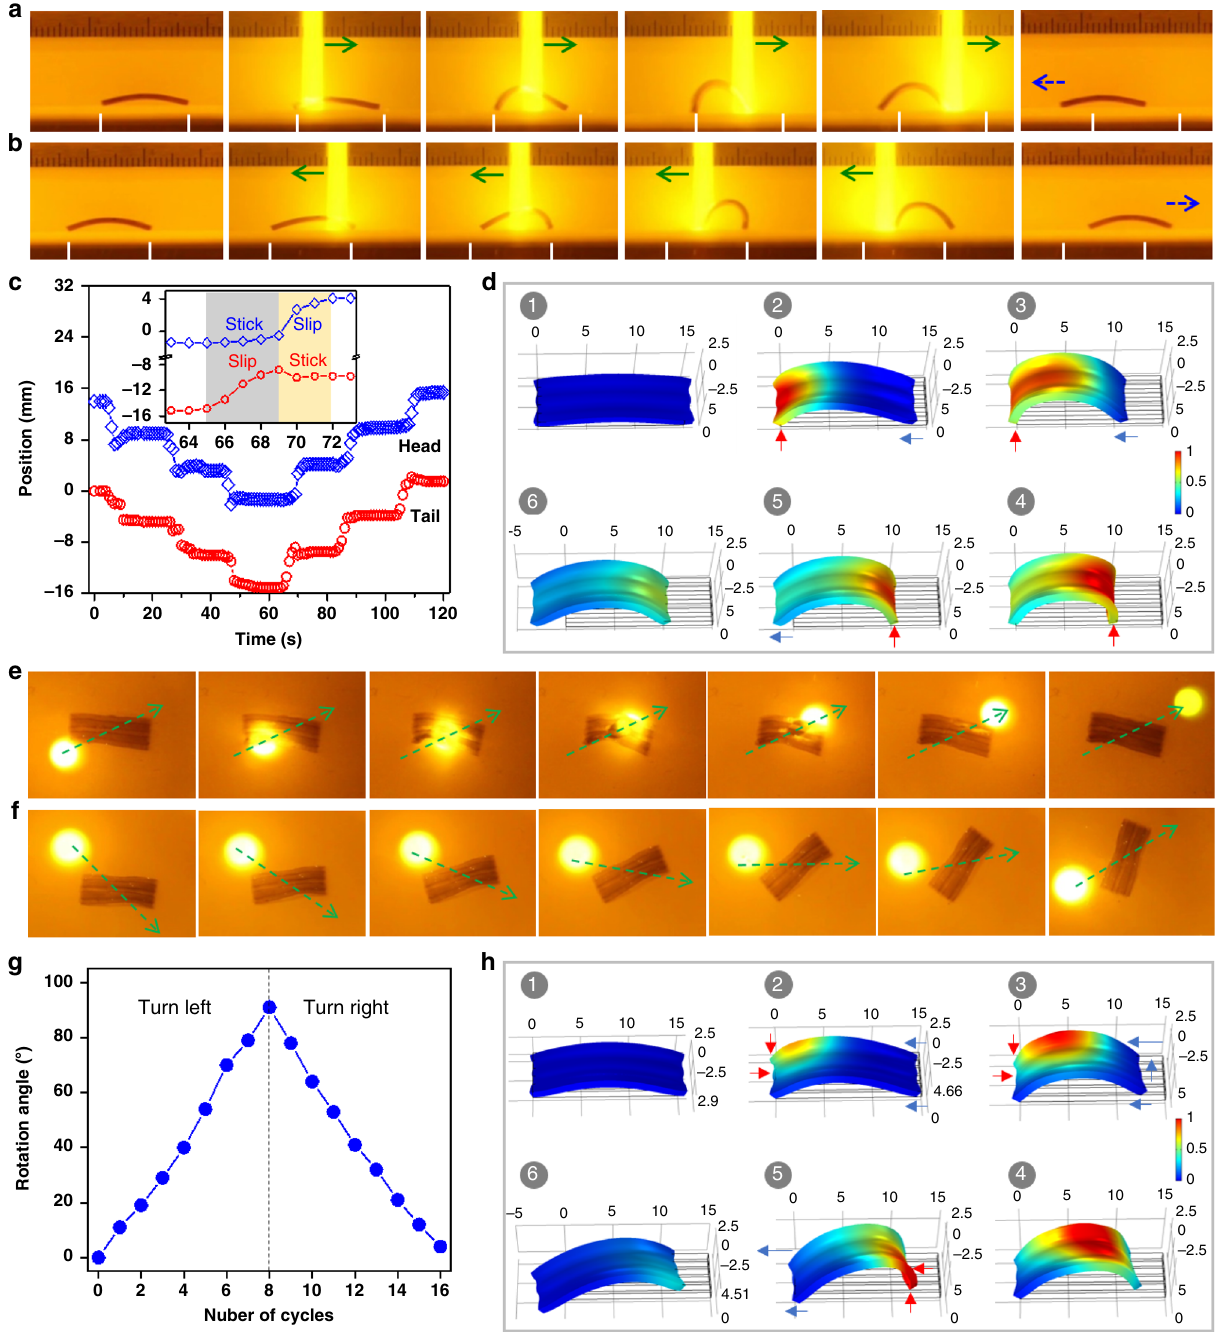
Fig. 5 Photo-steered walking and turning of the patterned anisotropic hydrogel. a , b Snapshots to show the walking gait of the stripe-patterned anisotropic hydrogel under the scanning of a light beam from left to right ( a ) and from right to left ( b ). Green and blue arrows indicate the light scanning direction and motion direction, respectively. c Displacements of the two ends (heat and tail) of the gel under cyclic scanning of light. d Simulation results showing the kinematics of the retrograde walking of the hydrogel based on photo-directed buckling and dynamic adhesion. e – g Snapshots to show the turning motion in one cycle of light scanning ( e ), and the sequential turning motions ( f ) and accumulated rotated angle ( g ) of the pattern hydrogel under cyclic scanning of a light beam along the diagonal direction of the gel. Green arrows indicate the light scanning directions. h Simulation results showing the kinematics of the turning motion of the hydrogel under the scanning of light. The red and blue arrows indicate the anchoring spot and motion direction of the gel. Color scale in the simulated results indicates the normalized temperature. Gel dimensions, 15 mm × 5 mm × 1 mm; power intensity, 3.5 W cm − 2 ; scanning speed, 1.7 mm s − 1